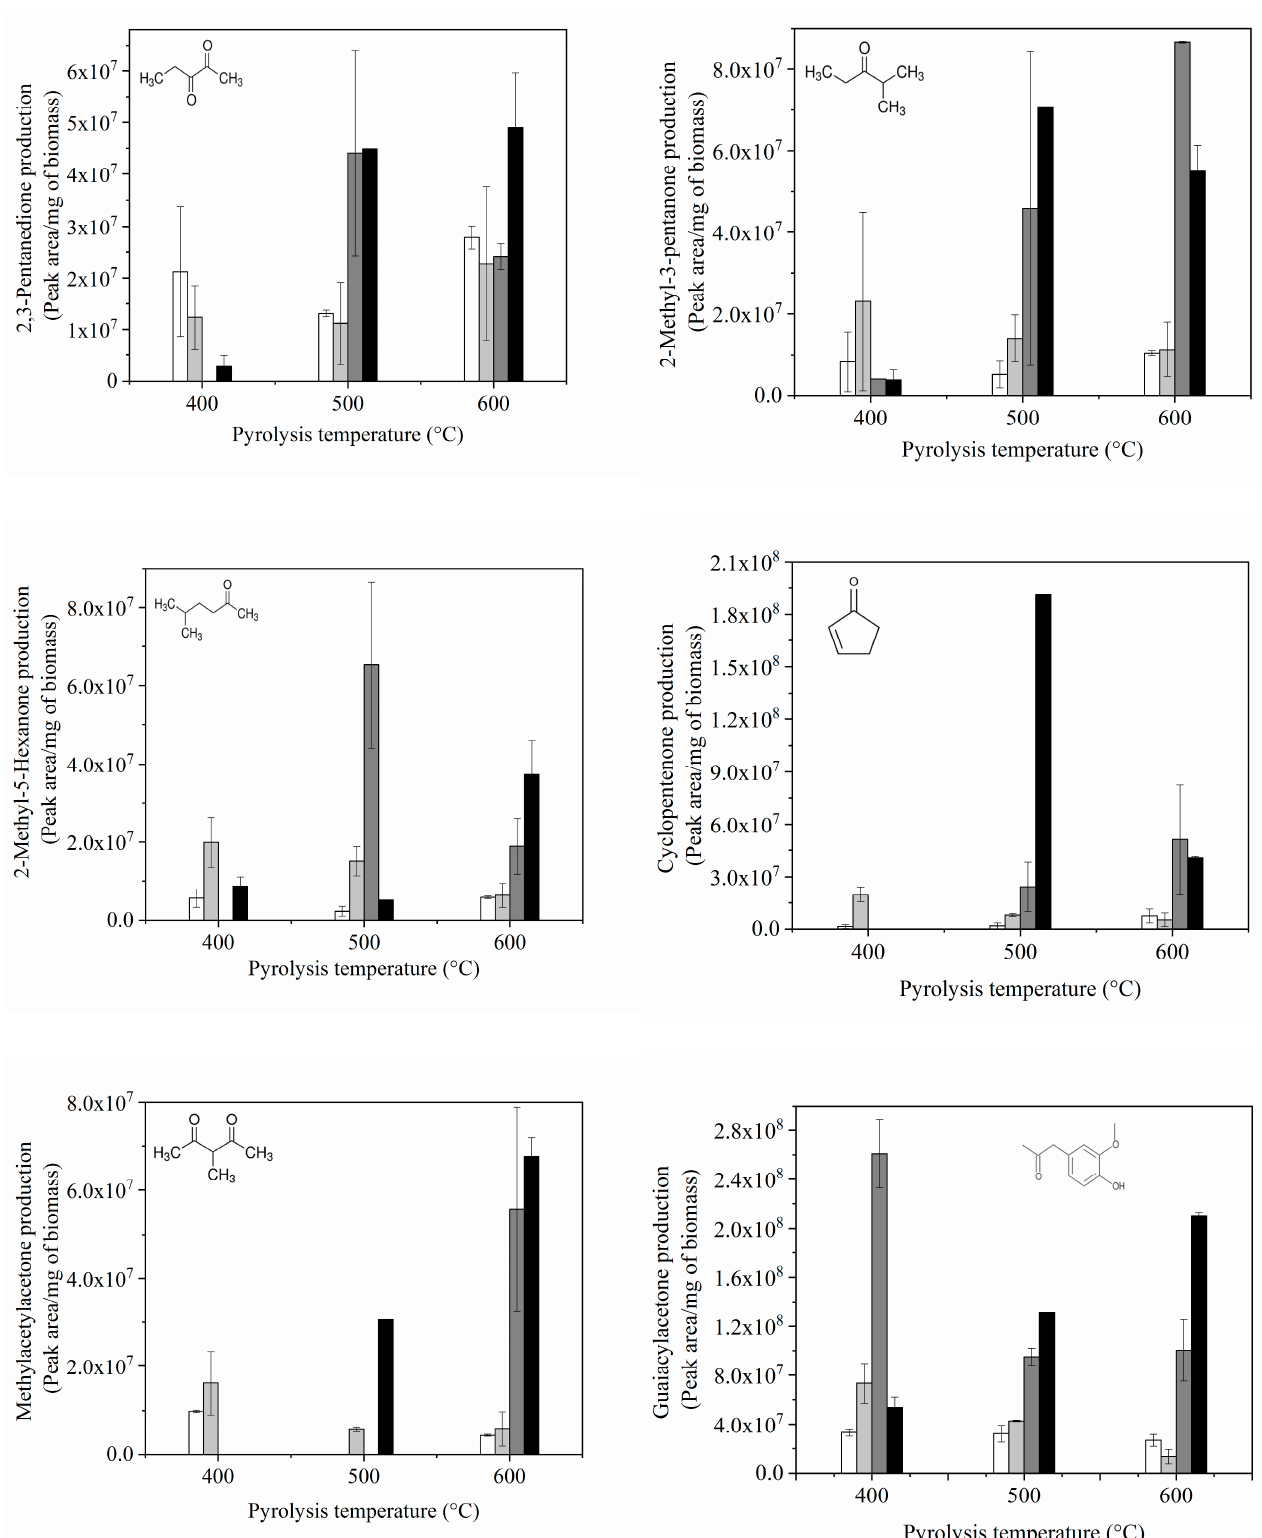
Figure 9. Formed oxygenated pyrolytic compounds (>5 Carbons) from coffee husks as a function of pyrolysis temperature and pretreatment acid type. Symbols: (cid:3) Untreated biomass; (cid:4) biomass pretreated with acetic acid; (cid:4) biomass pretreated with HNO 3 (0.1%)/H 2 SO 4 (0.1%); (cid:4) biomass pretreated with H 2 SO 4